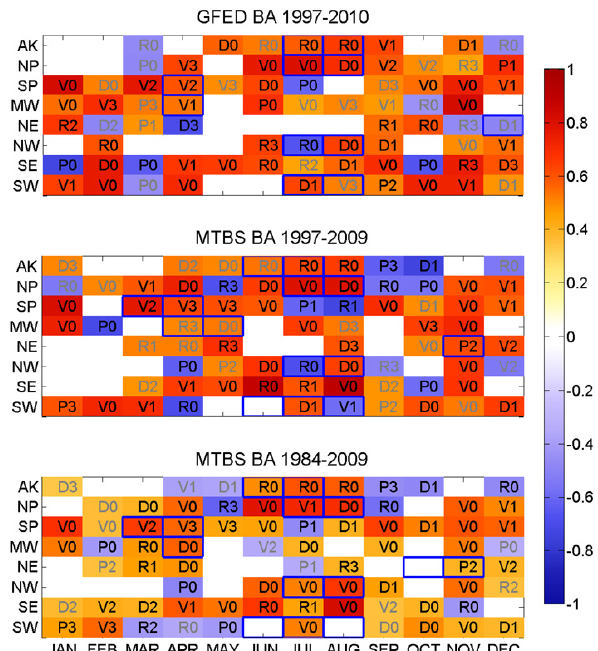
Fig. 8. Maximum monthly cross correlation coefficients between GFED (top) and MTBS (middle, 1997–2009; bottom, 1984–2009) BA and alternate climate indices. Letters in each grid cell indi- cate the monthly mean climate variable ( R : shortwave radiation, V : vapour pressure deficit, P : precipitation; D : water deficit, cal- culated as P -PE), numbers represent the lead time between climate and BA in months (max = 3), and colours represent the Pearson’s correlation coefficient. Black text indicates correlation coefficients with p < 0.05, and grey text signifies correlation coefficients with 0.05 ≤ p < 0.1. Months with < 2% of annual BA or without sta- tistically significant correlations between BA and climate variables ( p > 0.1) appear white. Blue boxes outline months with ≥ 20% of annual BA for each region.